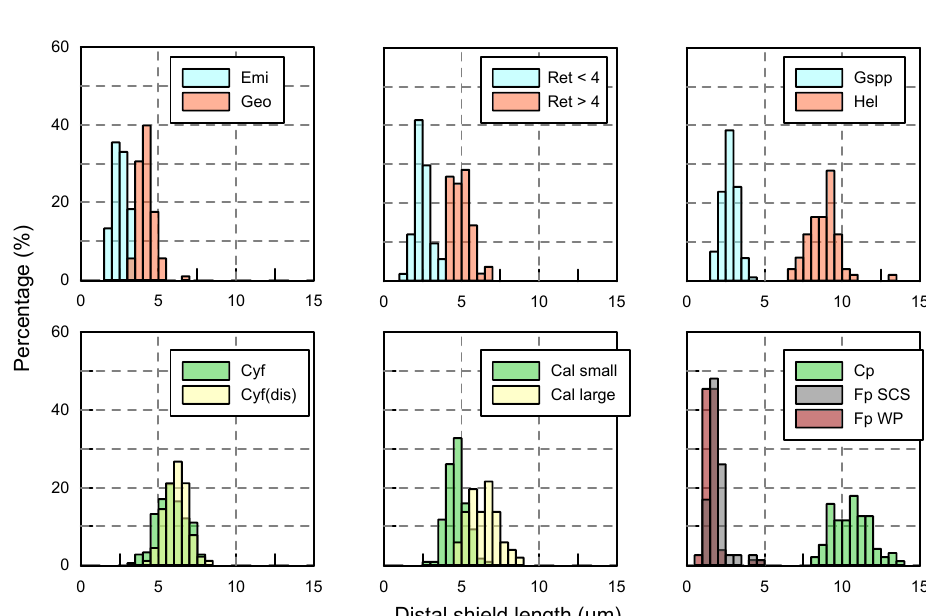
Figure C1. Size distribution of coccoliths measured in the present study. The abbreviations of coccolith names follow Table